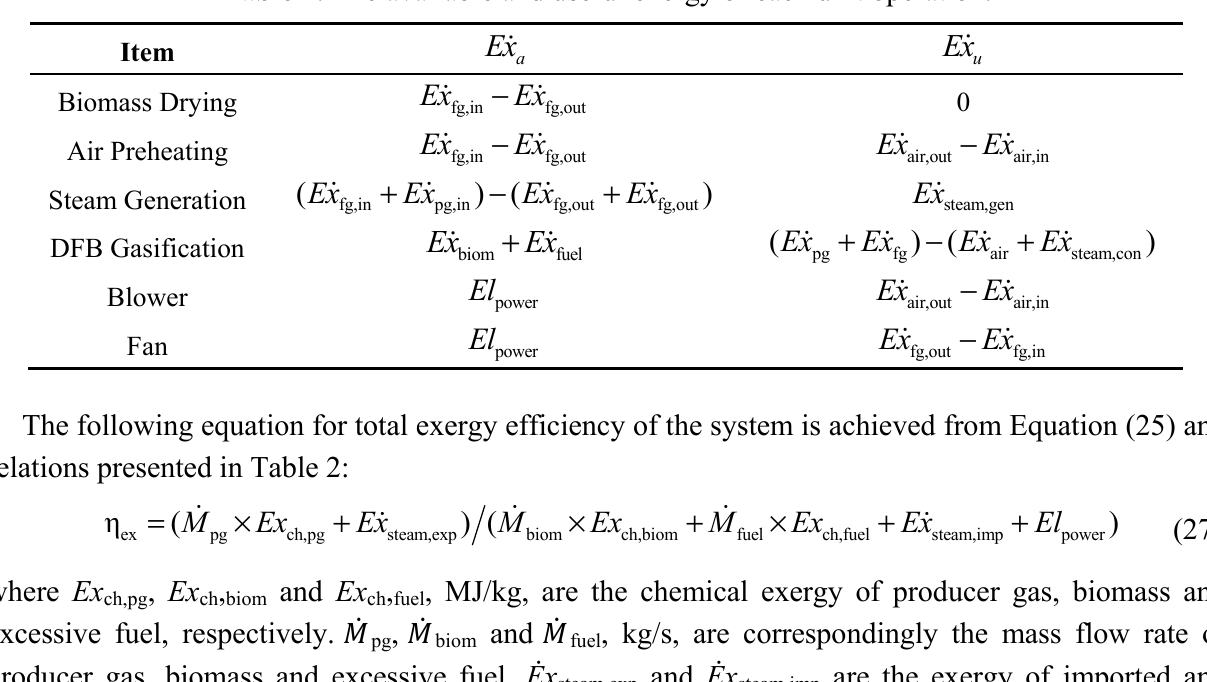
Table 2. The available and useful exergy of each unit